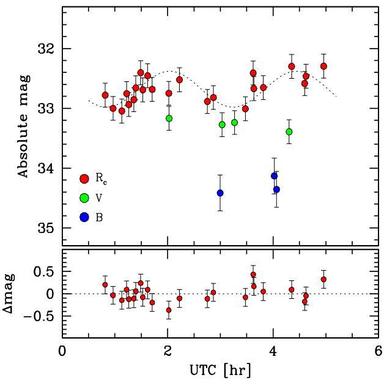
The Loiano observations of are merged in the upper plot, after rescaling to absolute magnitudes. The displayed pattern in both 2015 November nights for the WT1190F R magnitude to change on a tentative timescale of 2.4 h is reinforced here, as a (somewhat speculative) evidence of a coherent object variability with an amplitude of about 0.7 mag (dotted curve). The magnitude residuals with respect to a fitting sinusoidal curve have a rR ¼ 0:18 mag (rms) and are displayed in the lower panel. See tex